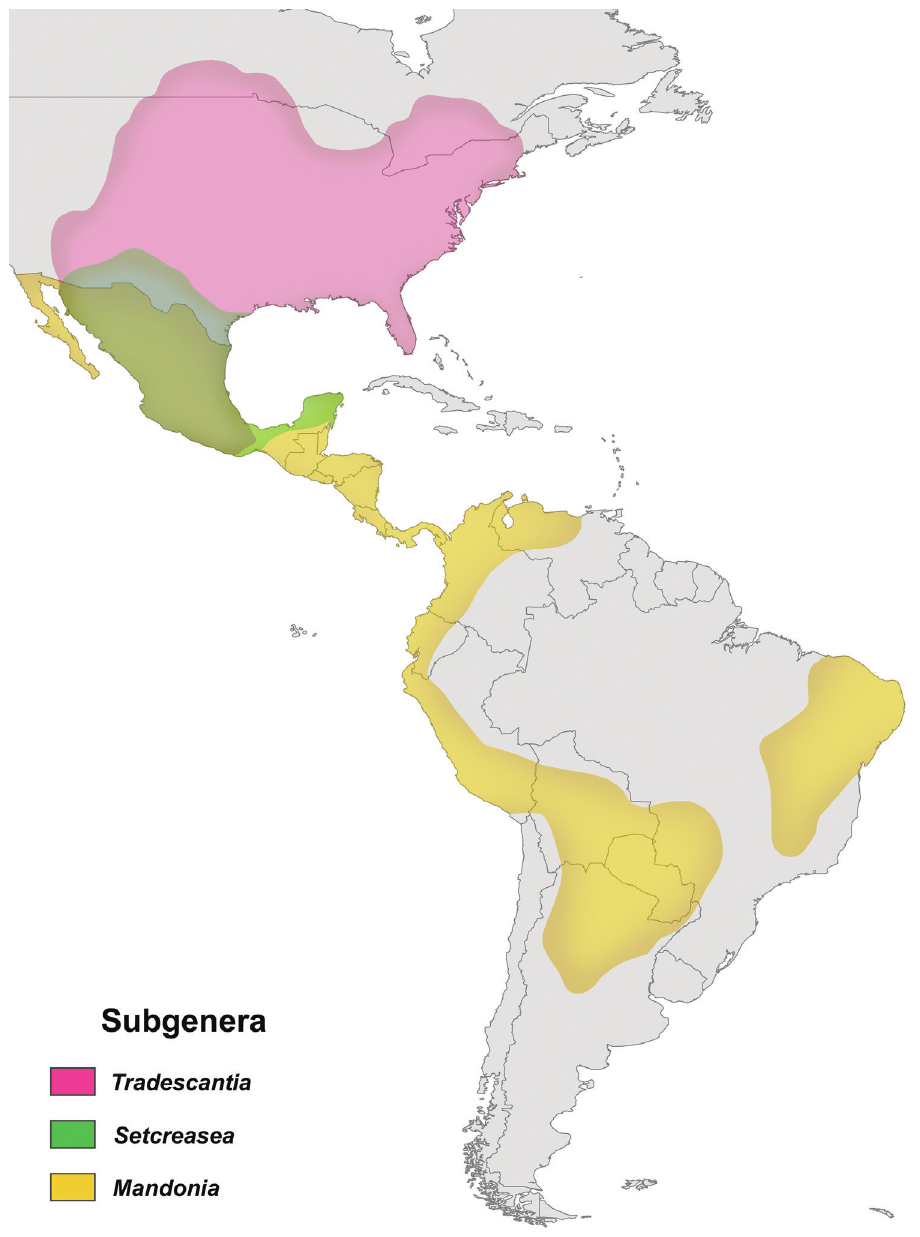
Figure 11. Distribution of Tradescantia subg. Mandonia (D.R.Hunt) M.Pell. in yellow, of T. subg. Set- creasea (K.Schum. & Sydow) M.Pell. in green, and Tradescantia L. subg. Tradescantia in